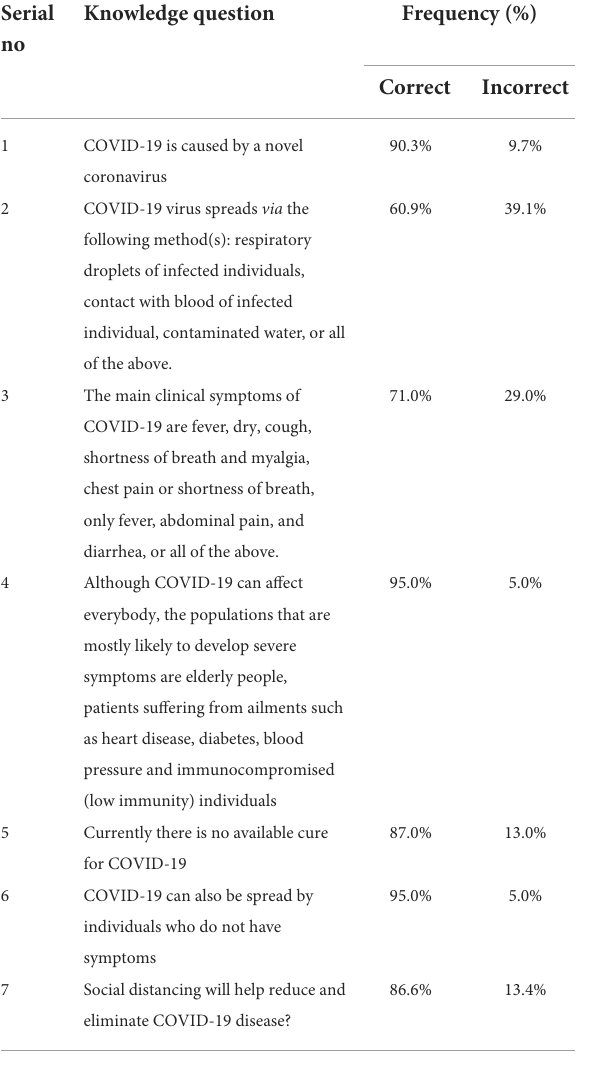
TABLE 3 Attitude responses toward COVID-19 among solid organ transplant recipients ( N =